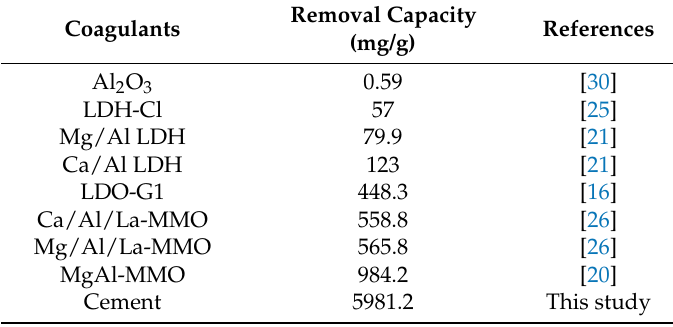
Table 1. Comparisons of the coagulation capacity of graphene oxide (GO) with different coagulants.